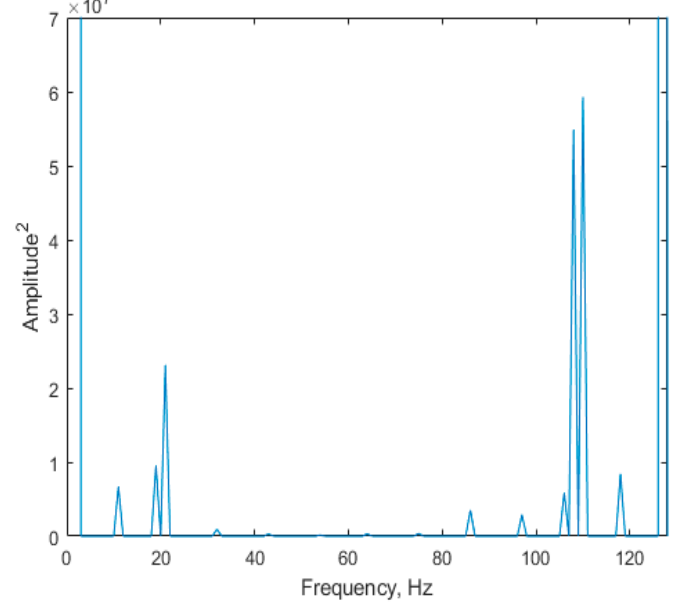
Figure 23. Amplitude NC spectrum of a received signal.